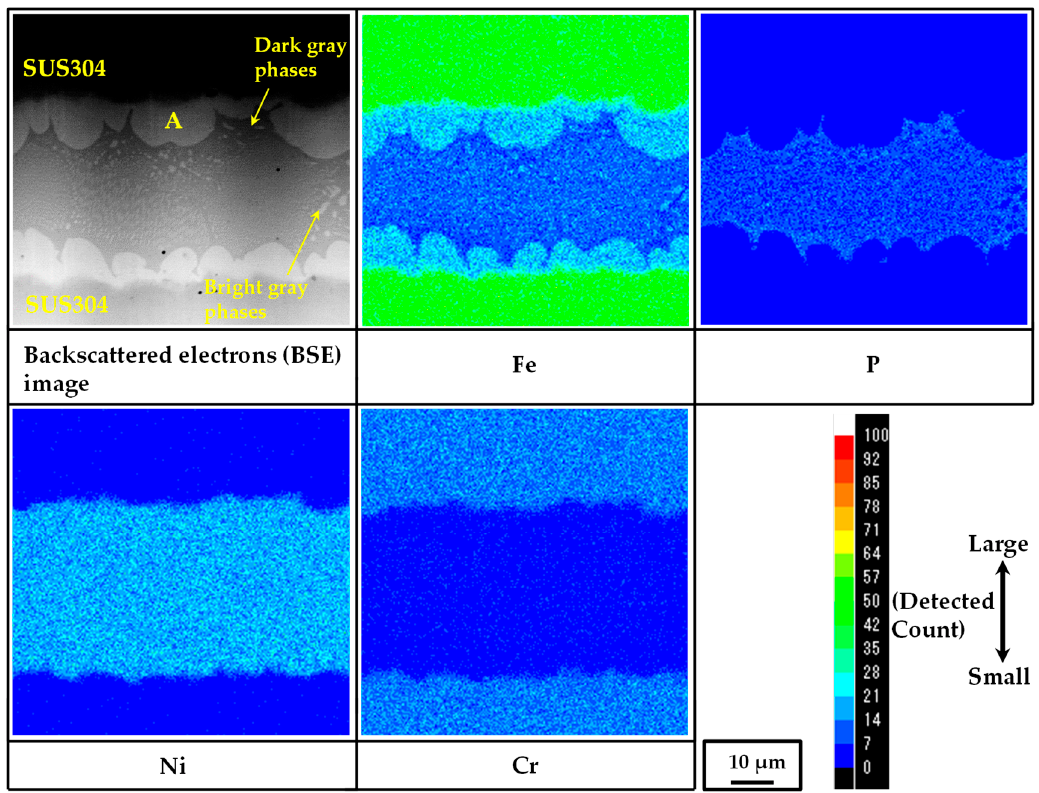
Figure 6. EPMA mapping analysis results for brazed joint with Ni-11P plated layer. The plated layers used for brazing tests were obtained in the bath containing 0.4 M H 3 PO 3 in the case of a current of 2.0 A/dm 2 and a plating time of 90 min.